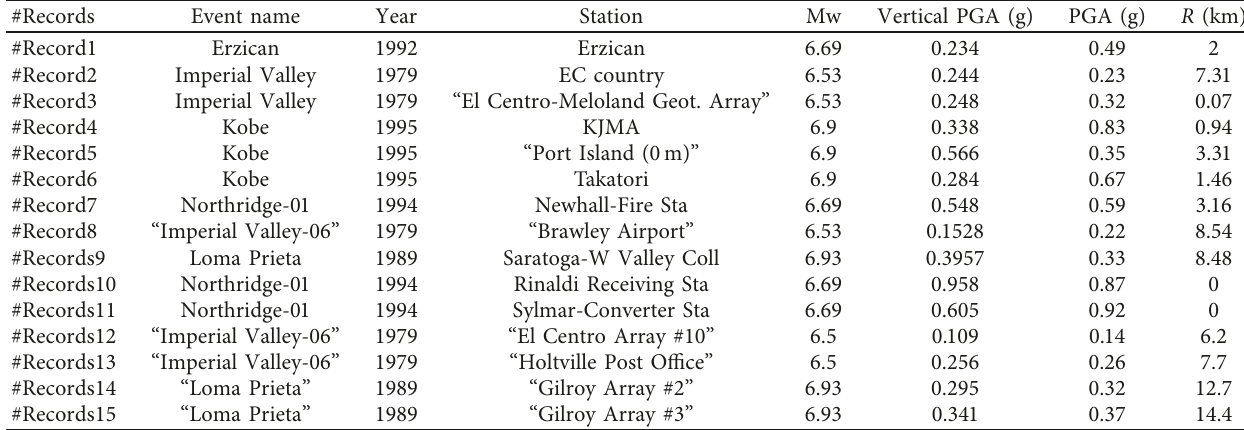
Figure 6: Elastic response spectral acceleration for near-field Table 2: Near-field records.